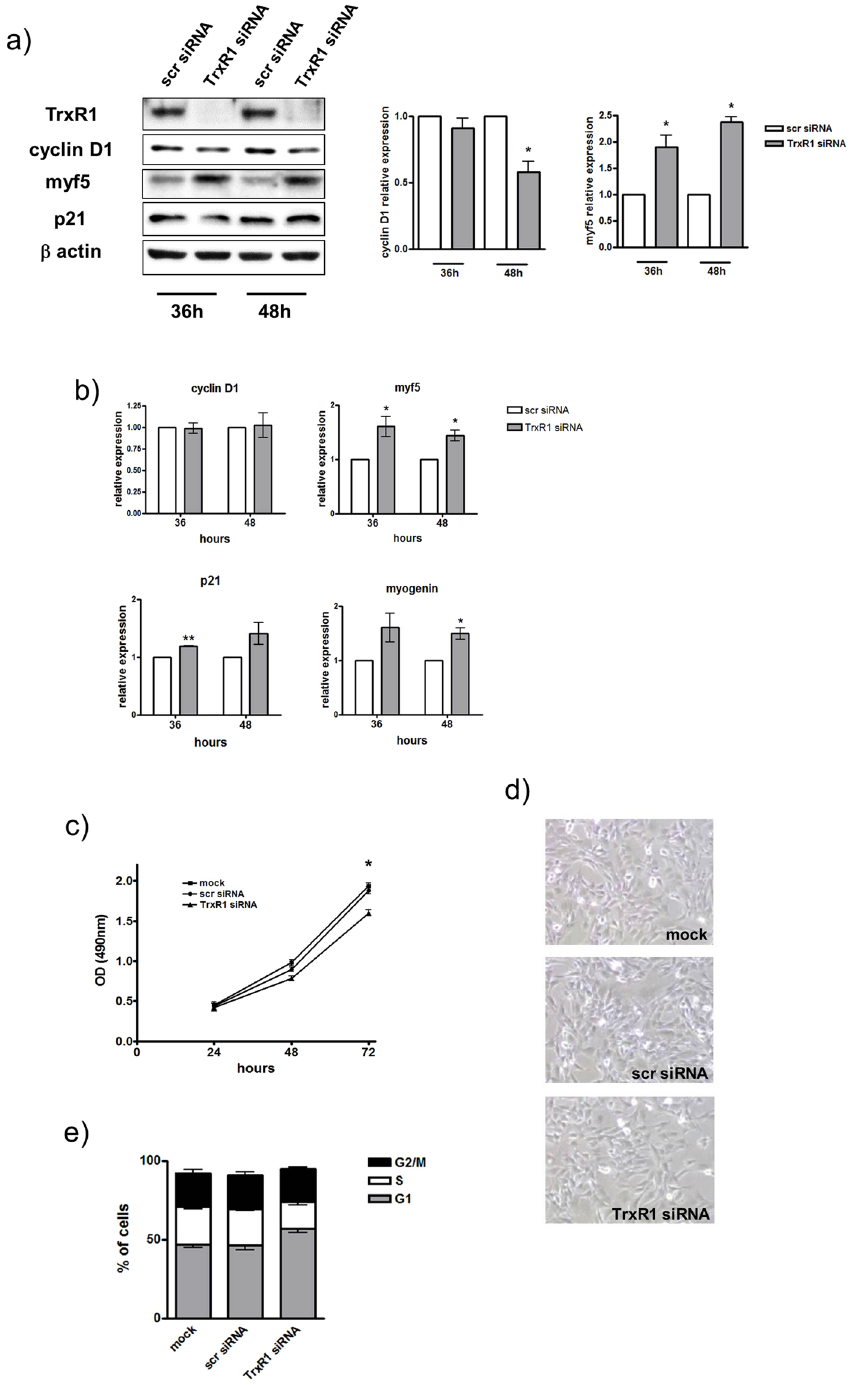
Figure 2. The siRNA-mediated TrxR1 inhibition reduces C2C12 cell growth and induces an early myogenesis- related gene expression pattern. C2C12 myoblasts were transfected with a scramble siRNA (scr siRNA) or a siRNA against TrxR1 sequence (TrxR1 siRNA) and cultivated in GM for 24–72 hours. ( a ) Western blot analysis showing the protein levels of TrxR1, Cyclin D1, p21 and Myf5 at 36 and 48 hours after transfection and the histogram relative to quantification of Cyclin D1 and Myf5 protein levels, represented as mean ± SEM of five different western blot as in panel a. The TrxR1/ β -actin ratio of scr siRNA C2C12 is set = 1. ( b ) RT-qPCR analysis showing the mRNA expression levels of Myf5, Cyclin D1, p21 and Myogenin at 36 and 48 hours after transfection. Cyclophilin A mRNA was used to normalize the relative amount of each mRNA analysed. Results are represented as mean ± SEM of at least three different experiments. ( c ) MTS assay measured at 24, 48 and 72 hours after transfection. ( d ) Image (20x) showing cellular confluence at 72 hours. ( e ) Cytofluorimetric analysis showing cell cycle phase